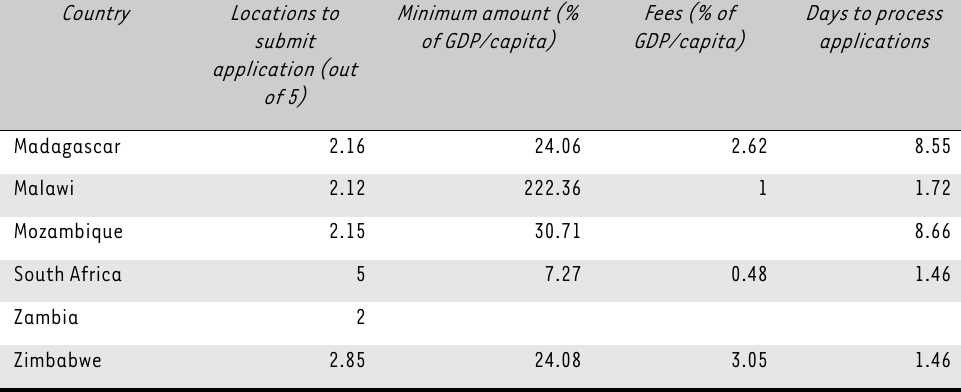
Fees (% of Days to process GDP/capita) applications